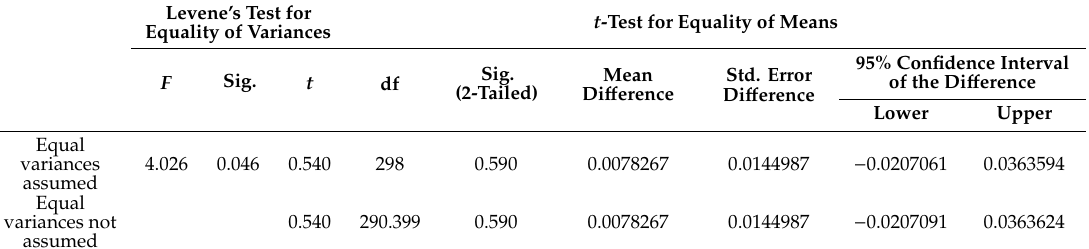
Table 8. T-Student test for TA property based on ANN-PSO